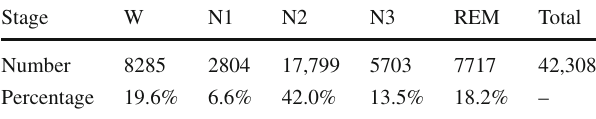
Table 2 Statistical results on sleep-EDF